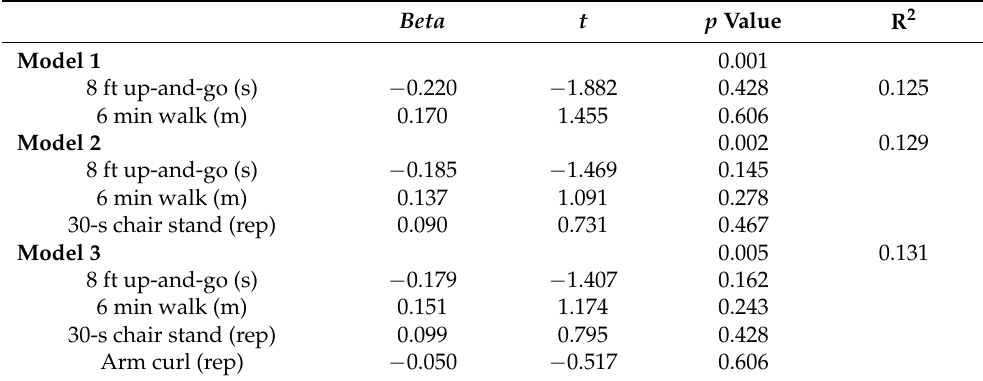
Table 4. Multiple linear regression (backward stepwise). Phase angle as a predictor for physical function. Total